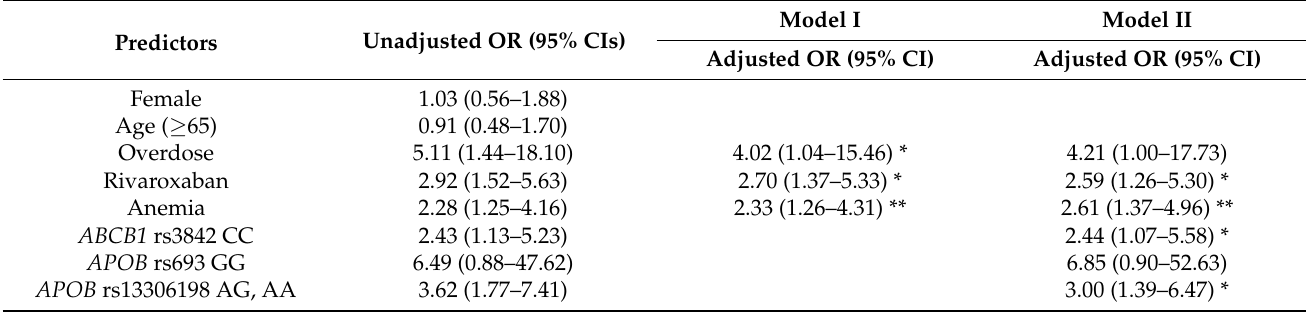
Table 4. Univariate and multivariable regression analyses to identify predictors for